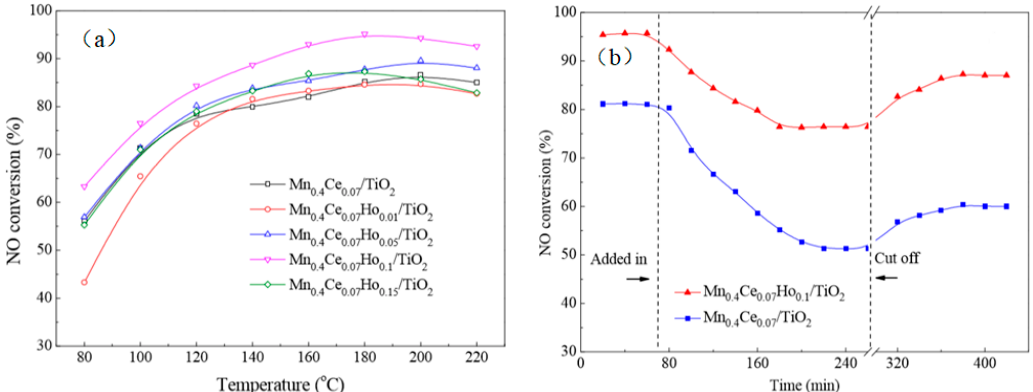
Figure 18. ( a ) Comparison of catalytic performance of different catalysts and ( b ) effect of SO 2 + H 2 O on NO conversion over Mn 0.4 Ce 0.07 /TiO 2 and Mn 0.4 Ce 0.07 Ho 0.1 /TiO 2 catalysts [108].